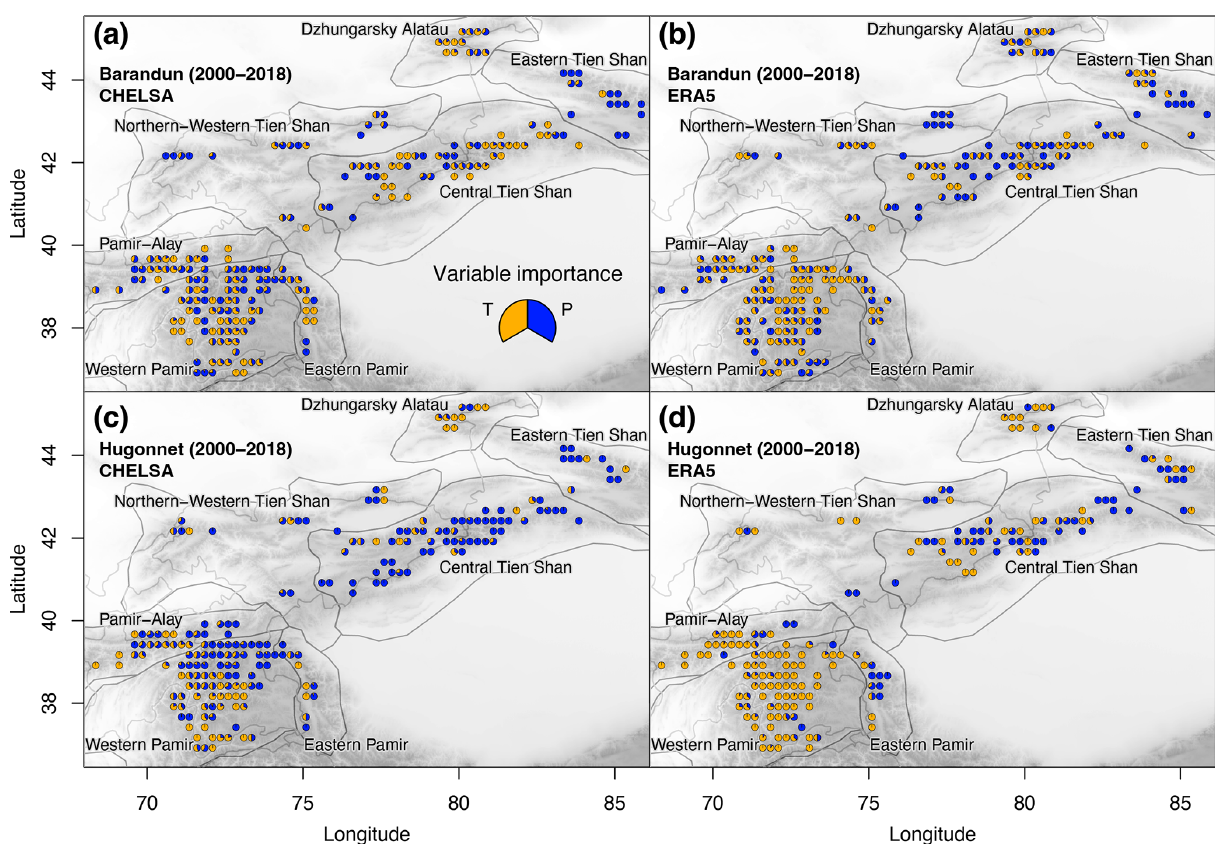
Figure A8. Importance of meteorological variables for temporal analysis between annual mass balance estimates from (a, b) Barandun et al. (2021a) and (c, d) Hugonnet et al. (2021) and two meteorological variables ( T and P ) from the different reanalysis